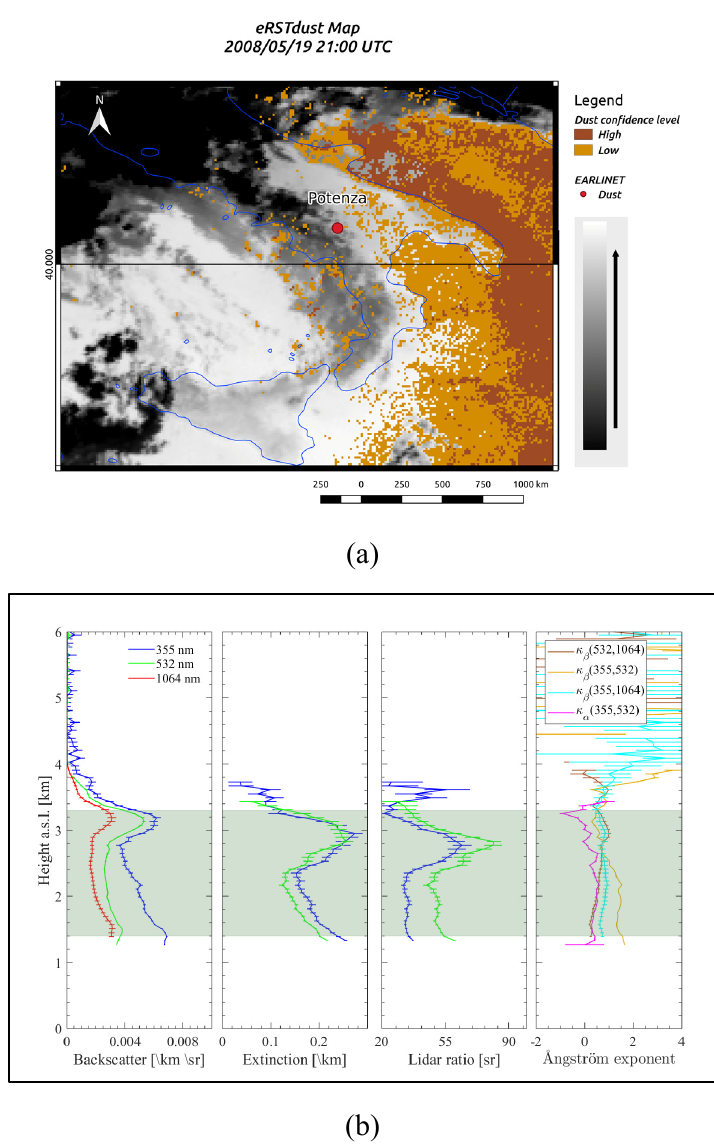
Figure 1. ( a ) e RST DUST map from SEVIRI (Spinning Enhanced Visible InfraRed Imager) data of May 19 at 21:00 UTC (magnified over Southern Italy and generated using the same algorithm arrangement of [27]), with the 10.8 µ m channel displayed in the background and the red dot indicating the concurrent dust identification of EARLINET (European Aerosol Research Lidar Network) (Potenza station). ( b ) Potenza EARLINET aerosol backscatter coe ffi cient, extinction coe ffi cient, lidar ratio and Ångström exponent profiles acquired the same day between 18:45–19:15 UTC. The green zone indicates the dust-a ff ected portion of the profile.